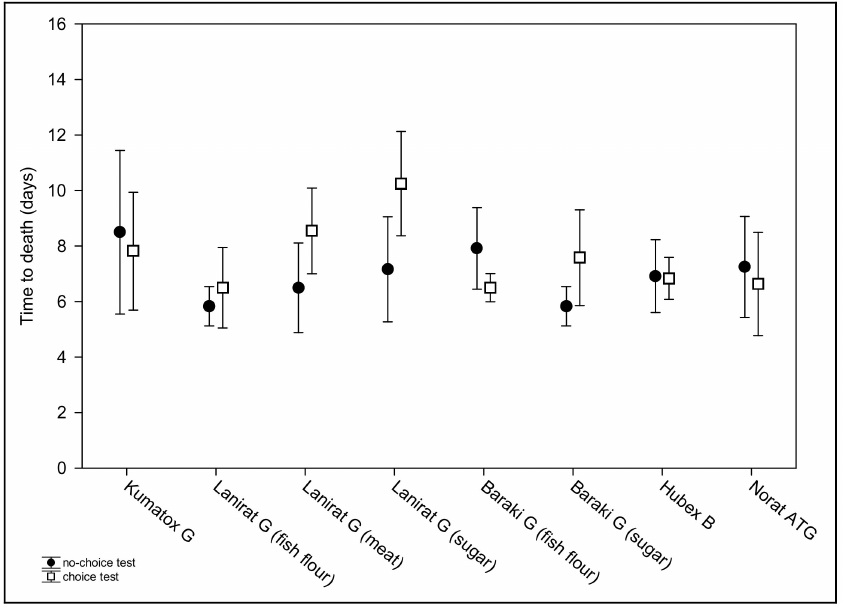
Figure 1. Average times to death of the tested house mice following consumption of baits either in no-choice (filled circles) or choice (empty squares) feeding trials. Data are presented as means and 95% CI.